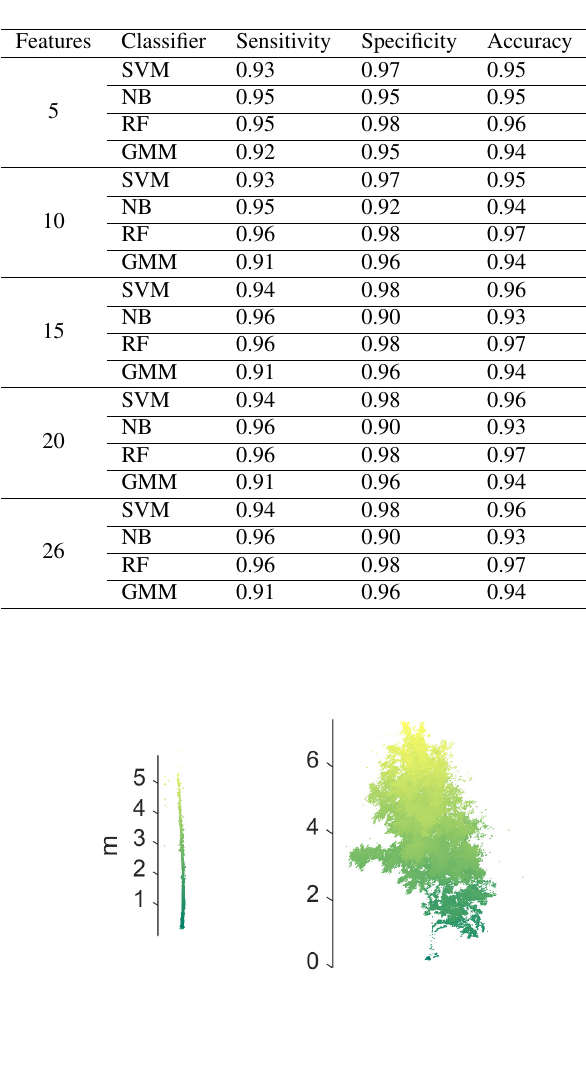
Table 3. Statistical evaluation of machine learning classifiers for the crown subset of the Erytrophleum fordii with 5, 10, 15, 20, and 26 features.